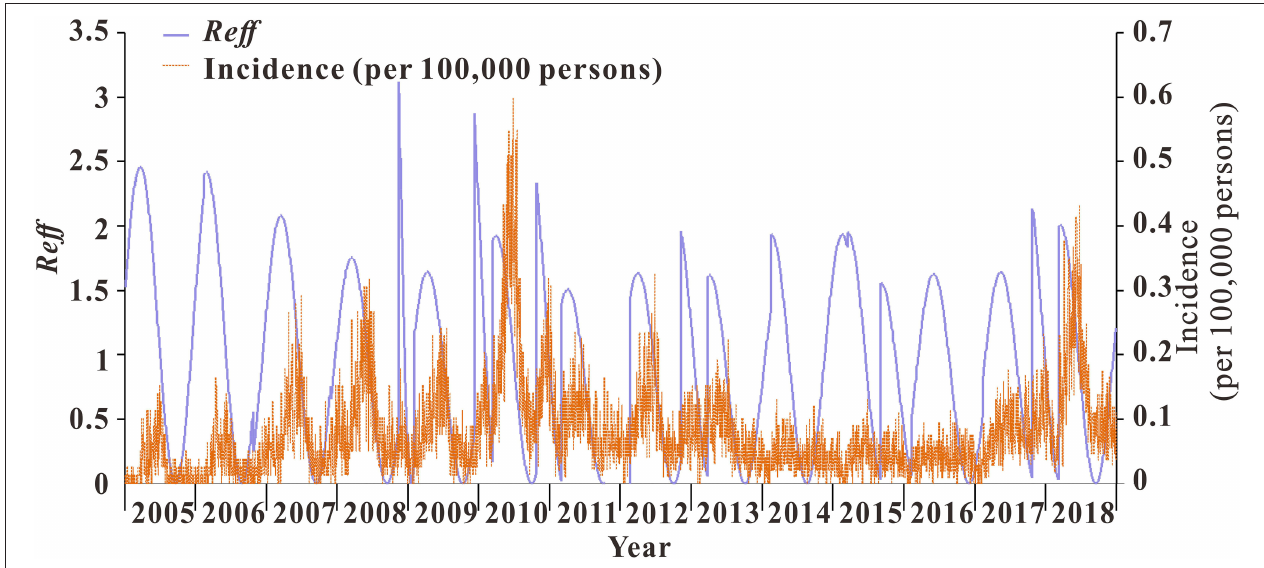
FIGURE 8 | Trend of incidence rates and transmissibility of mumps in Wuhan City.